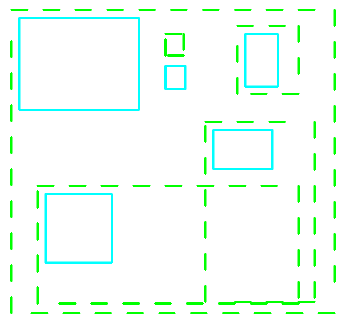
Figure 3. An example of learned anchor boxes: the anchor boxes for characters on DCM772 dataset (blue solid) and the original anchor boxes (green dashed) of YOLOv2 for objects on VOC dataset [81]. We can see that the boxes are very different in the two cases. Note that the spatial organization in this figure has no particular meaning, it is only for enhancing the visualization. The average IOU (see Equation (1)) of the ground-truth to closest prior of new anchor boxes and the original anchor boxes in YOLOv2 are, respectively, 67.62% and 51.13%, which shows that new anchor boxes provide a better representation of